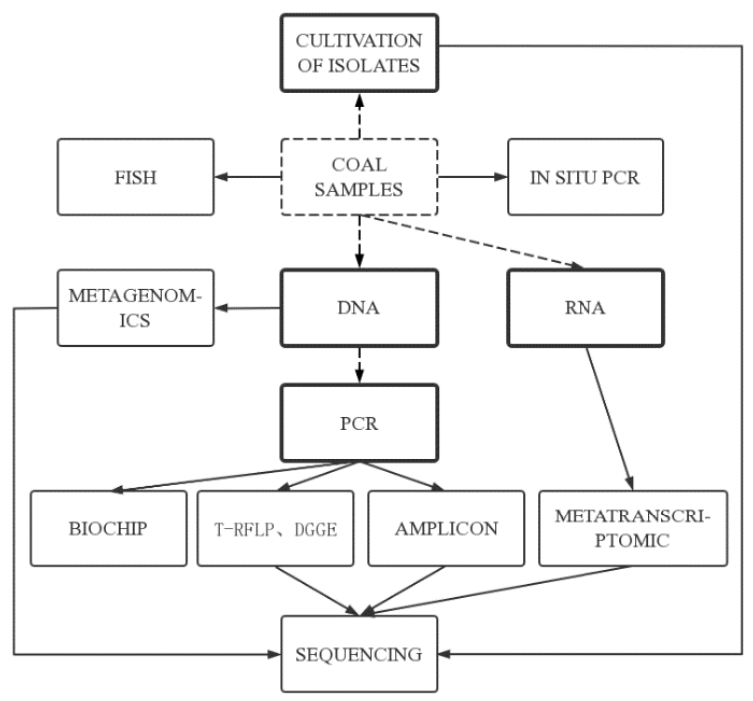
Figure 1. Common molecular approaches to study microbial diversity (Adapted from [30–32]). Boxes with bold frames indicate necessary preparatory steps before detection and analysis can be performed; boxes with thin frames represent detection techniques. FISH, fluorescent in situ hybridization; PCR, polymerase chain reaction; T-RFLP, terminal restriction fragment length polymorphism; DGGE, denaturing gradient gel electrophoresis.